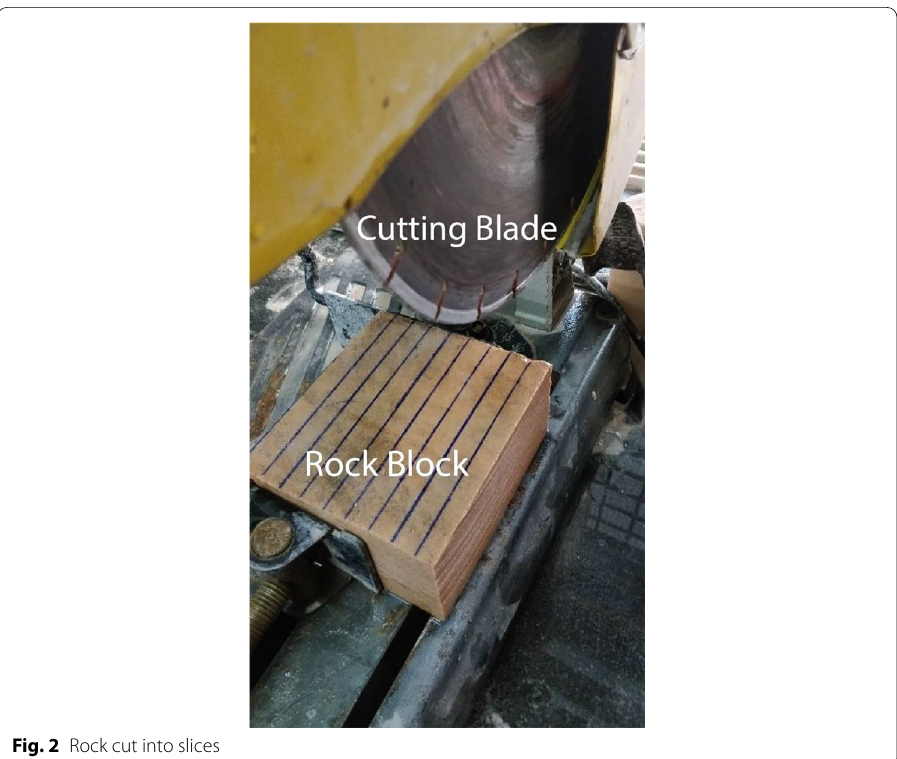
Fig. 2 Rock cut into slices